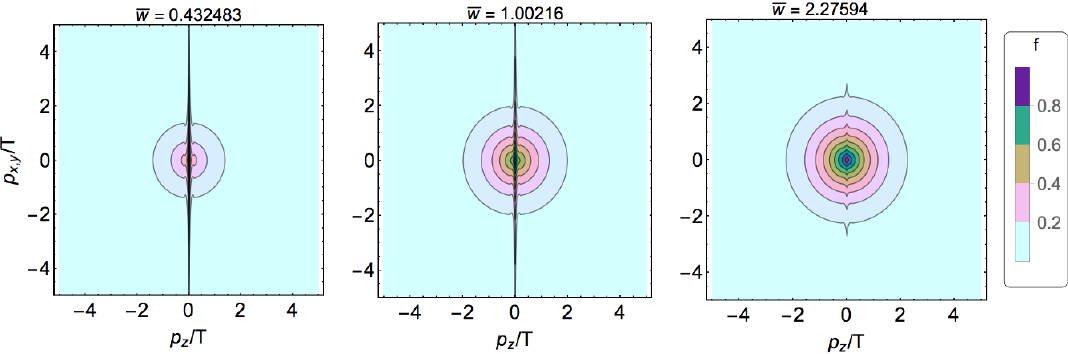
Figure 3 . Visualization of the one-particle distribution function associated with the